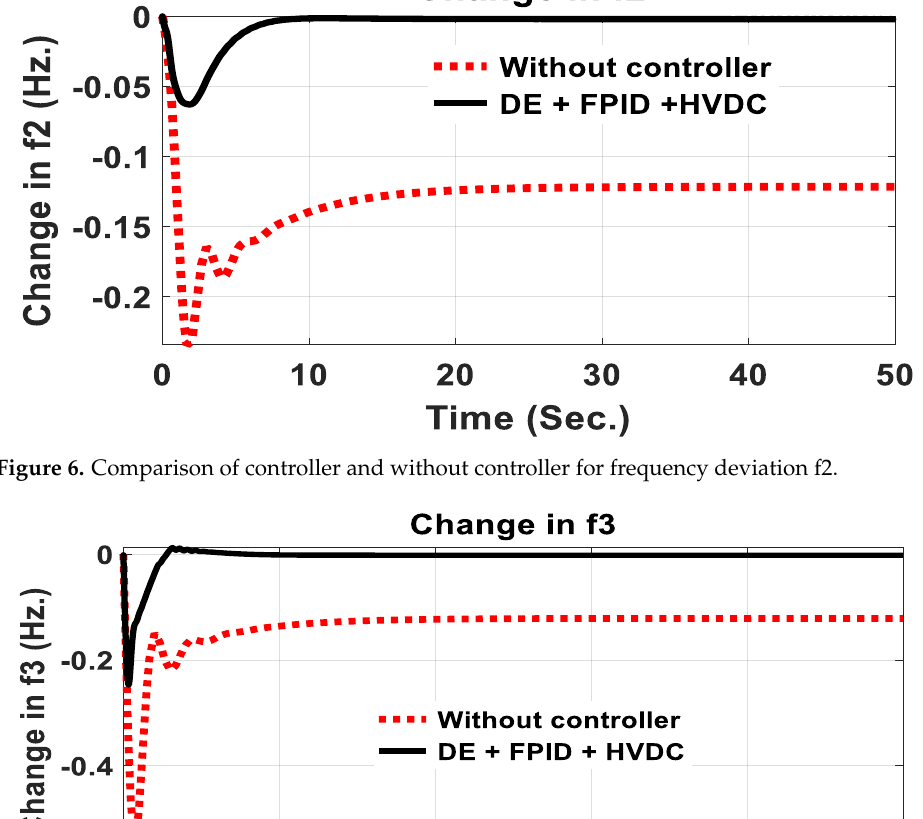
Figure 8. Comparison of controller and without controller for change in ACE 1. Figure 9. Comparison of controller and without controller forchange in ACE 2.